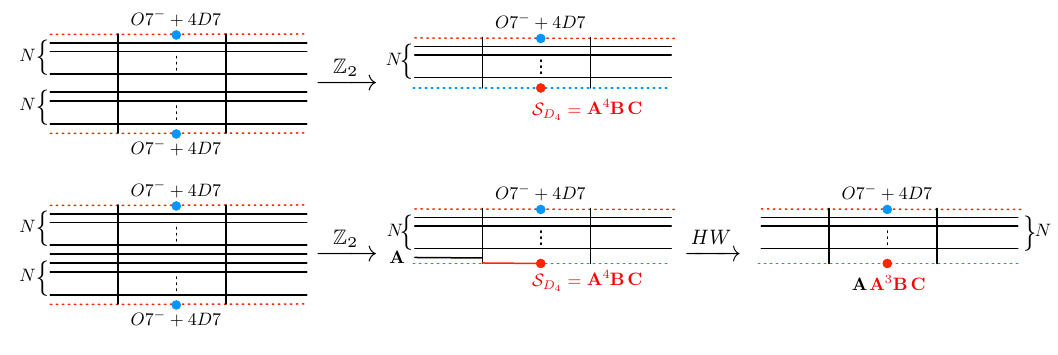
Figure 31 . 5-brane webs for 6d minimal (2 N + 4 , 2 N + 4) and (2 N + 5 , 2 N + 5) conformal